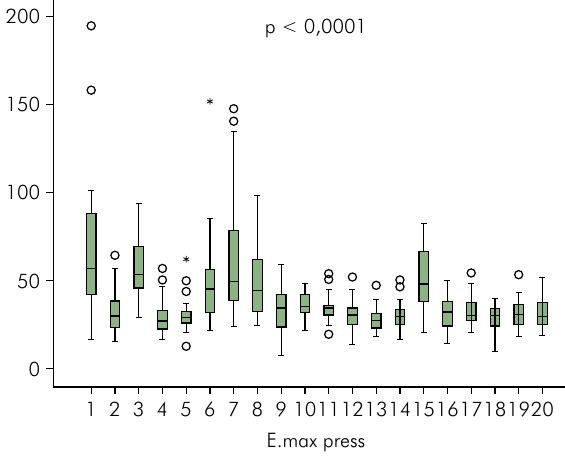
Figure 4. Data distribution for marginal gaps of crowns fabricated with the press technique in each tooth. The horizontal line in the boxes represents the median value in p < 0.0001